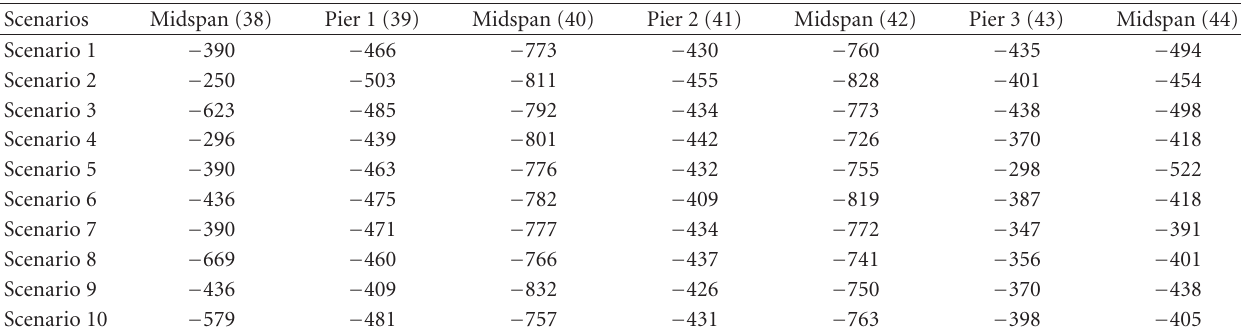
Table 10: Total stresses based on deflection measurements—north (psi ∗ ).